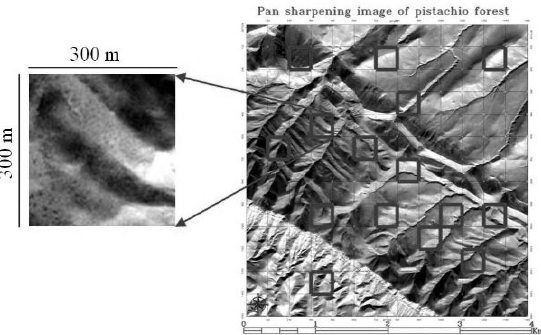
Figure 3. Arrangement of the 9-ha pistachio sampling plots. The 15 highlighted plots are those randomly chosen for analysis Juniper area